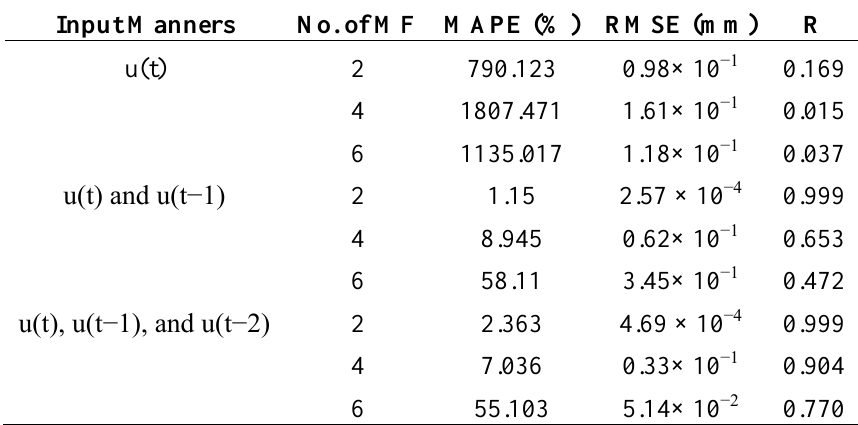
Table 2. Error analysis of monitoring GPS training